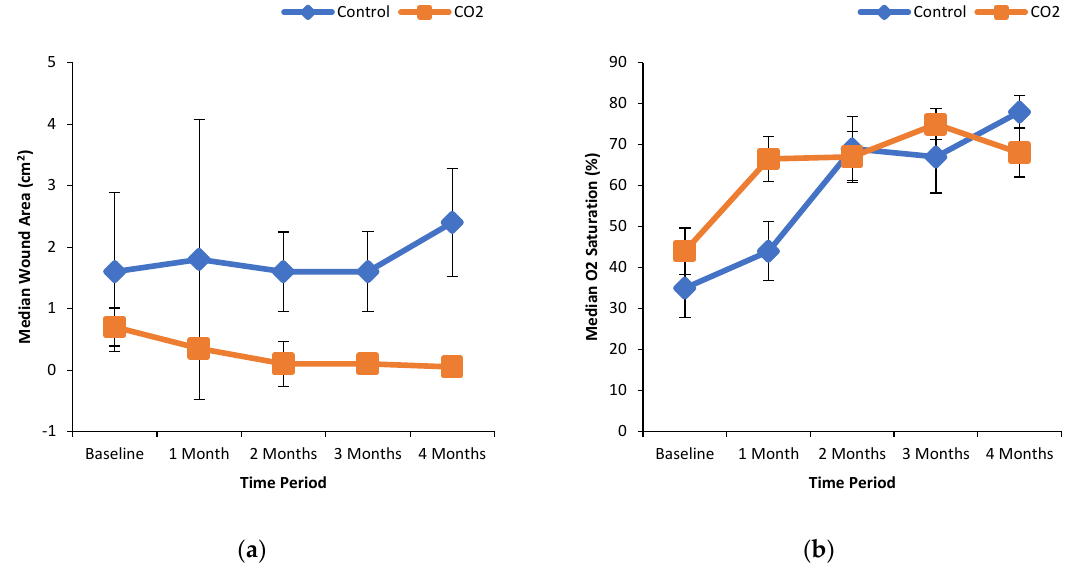
Figure 2. Oxygenated hemoglobin and oxygen saturation levels in the wound area in patients treated without and with CO 2 -enriched water. Panel ( a ) oxygenated hemoglobin levels in the wound area and panel ( b ) oxygen saturation levels of the wound in patients treated without and with CO 2 -enriched water. Participants underwent foot bathing with CO 2 -enriched tap water (37 ± 0.5 °C; CO 2 concentration of 1000 – 1200 ppm) or a regular tap water (37 ± 0.5 °C) with an immersion time of 15 min for 3 times/week for up to 16 weeks for a total of 48 treatment sessions. Non-invasive near infra-red spectroscopy was used to measure the percentage of oxygenated hemoglobin and oxygen saturation levels in the microcirculation of tissue up to 3 cm below the skin as described elsewhere [32].